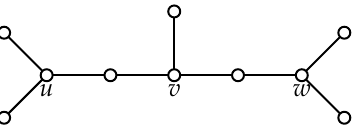
Figure 2. Caterpillar with one weak support v and two strong supports u and w